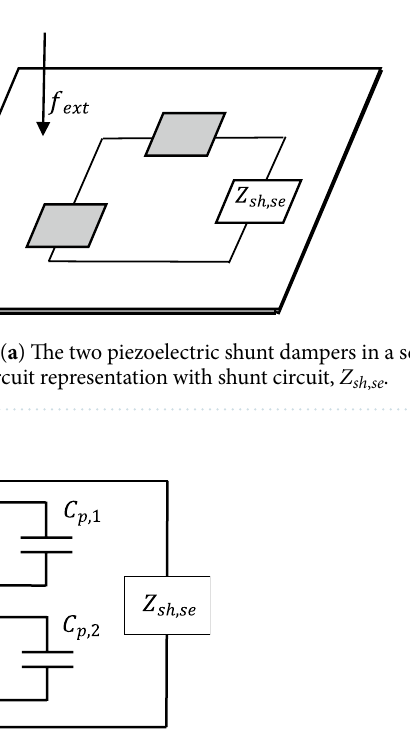
Figure 14. Equivalent electrical impedance representation of PZT shunt dampers in